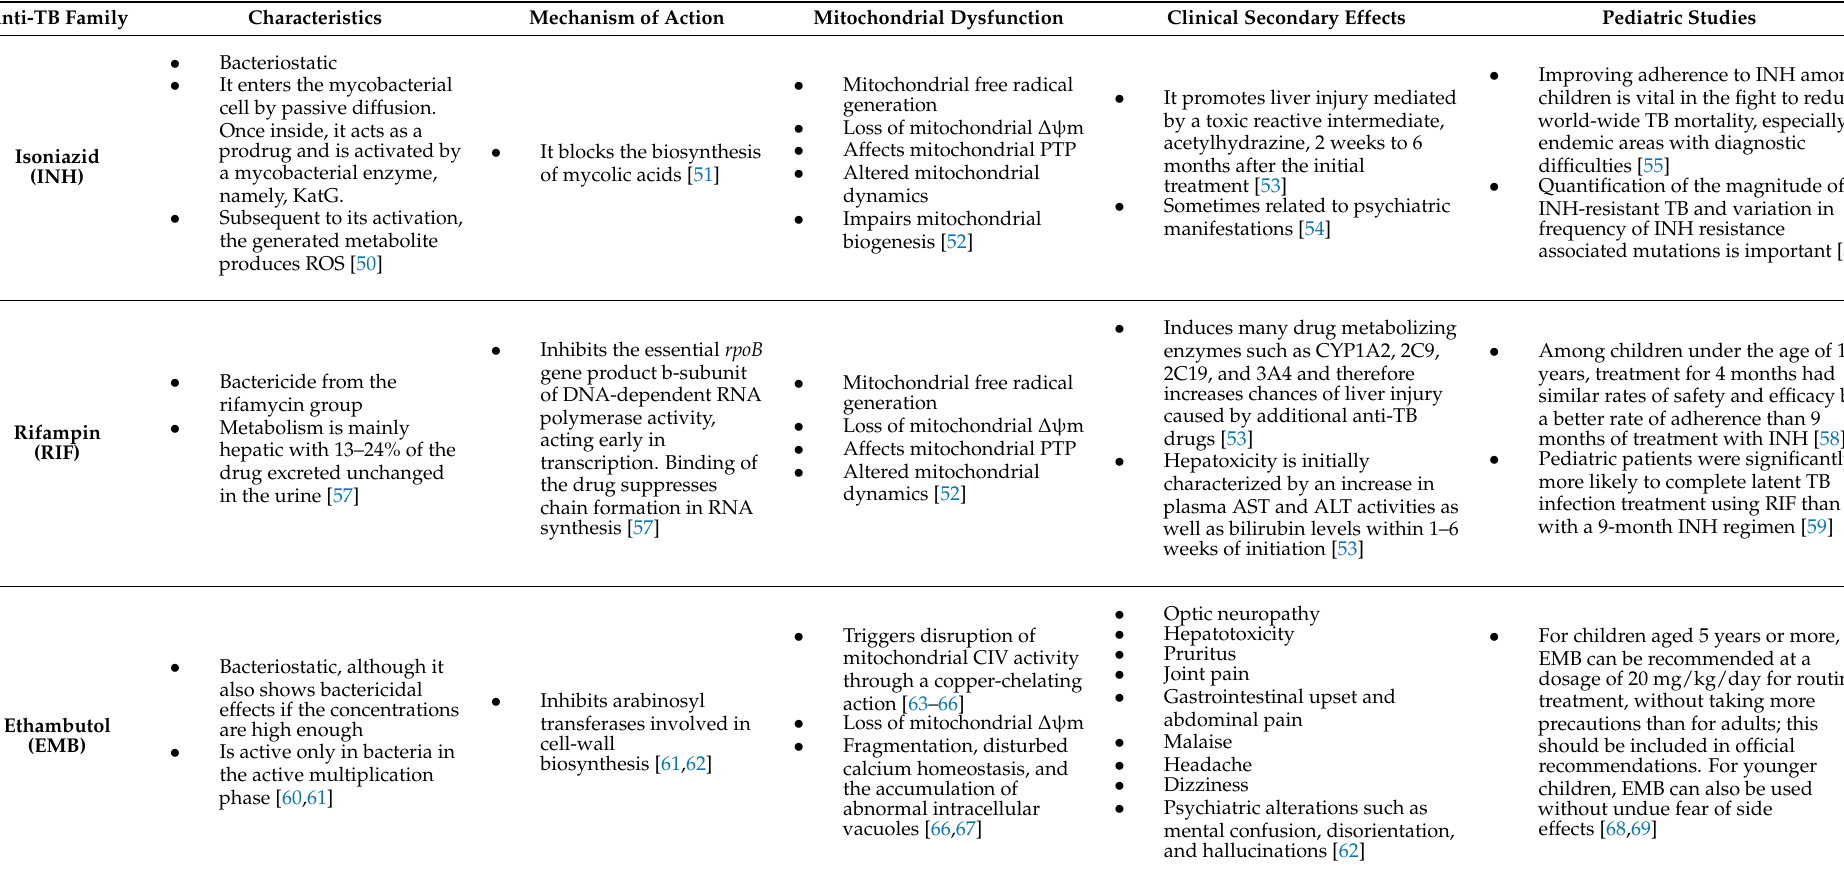
Table 3. Anti-TB first-line treatments, their mechanism of action, related mitochondrial dysfunction, and derived clinical adverse